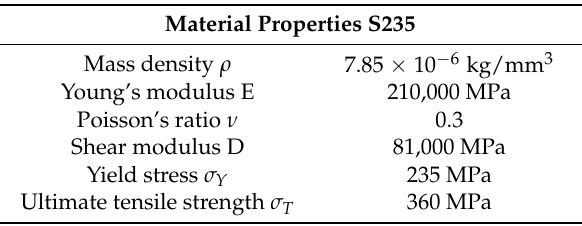
Table 2. Material